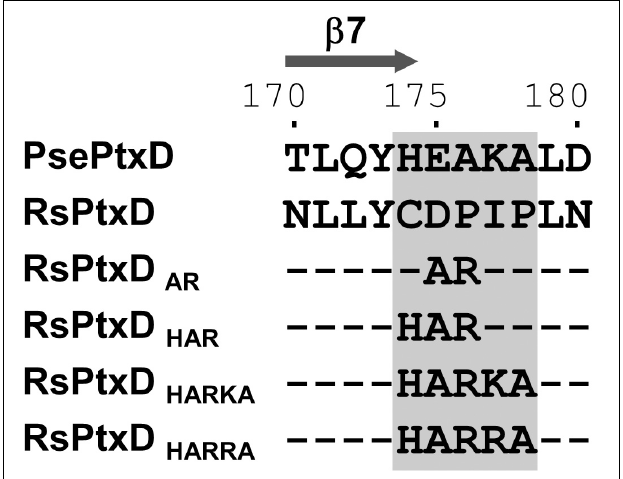
FIGURE 1 | The alignment of the amino acid sequences of PsePtxD, RsPtxD, and RsPtxD mutants. The mutations were introduced at the C-terminus region of the β 7-strand in the Rossmann-fold domain (gray rectangle). The comparison of the entire sequences of PsePtxD and RsPtxD is presented in Supplementary Figure 1